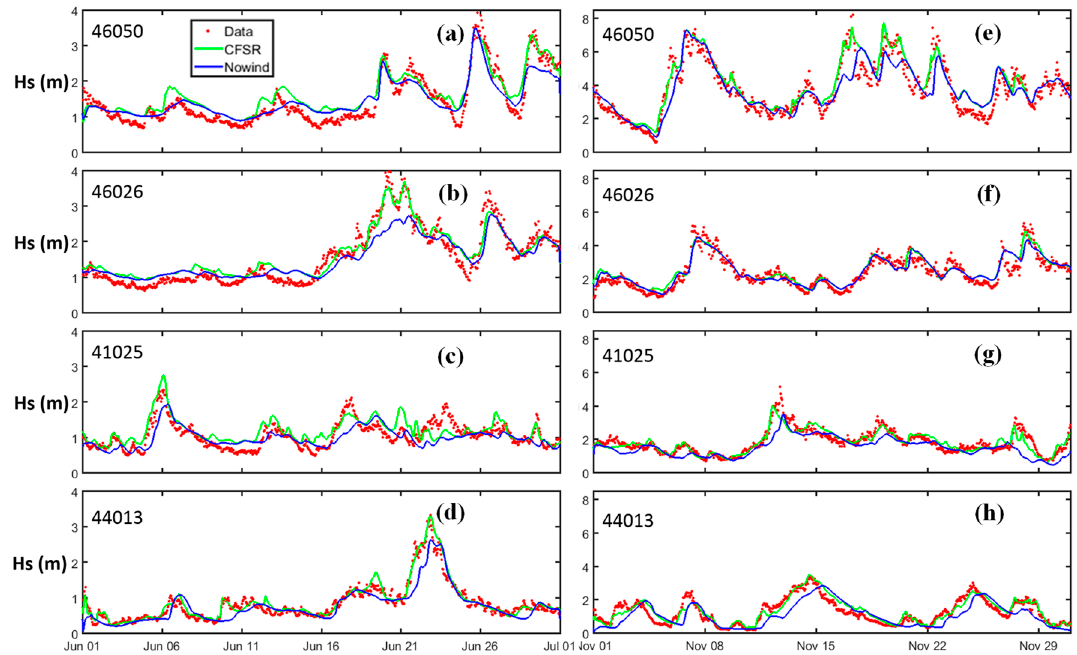
Figure 5. Comparison of significant wave heights between the baseline condition, no-wind condition, and buoy observations for the month of June ( a – d ) and November ( e – h ) in